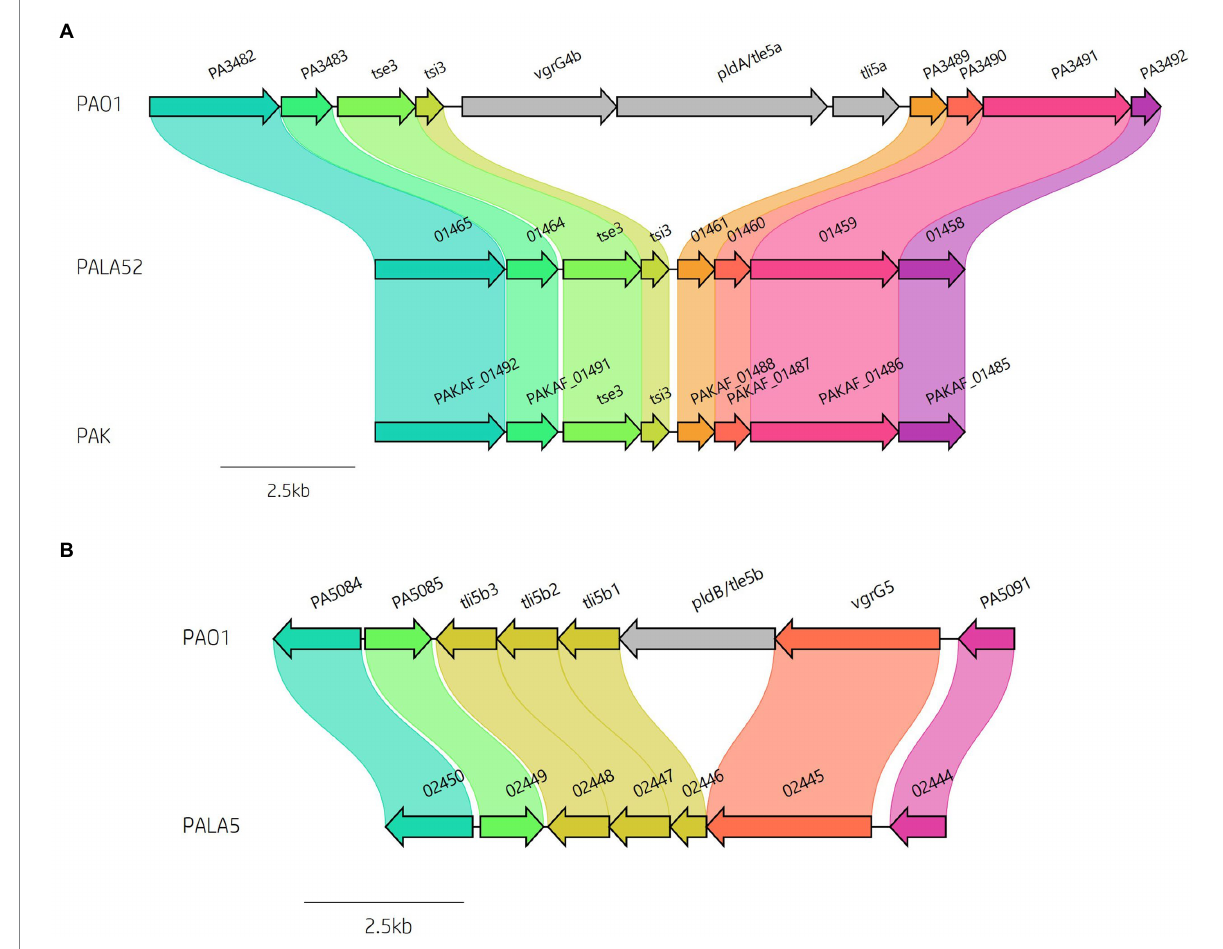
FIGURE 8 Comparative visualisation showing variation in the presence of the (A) vgrG4b and (B) vgrG5 islands encoded within the genomes of clinical isolates compared to reference P. aeruginosa strains PAO1 and PAK. Isolate PALA52 and PAK are used as representatives for the absence of the vgrG4b island. Isolate PALA5 shows deletion of the region encoding the phospholipase effector pldB/tle5b